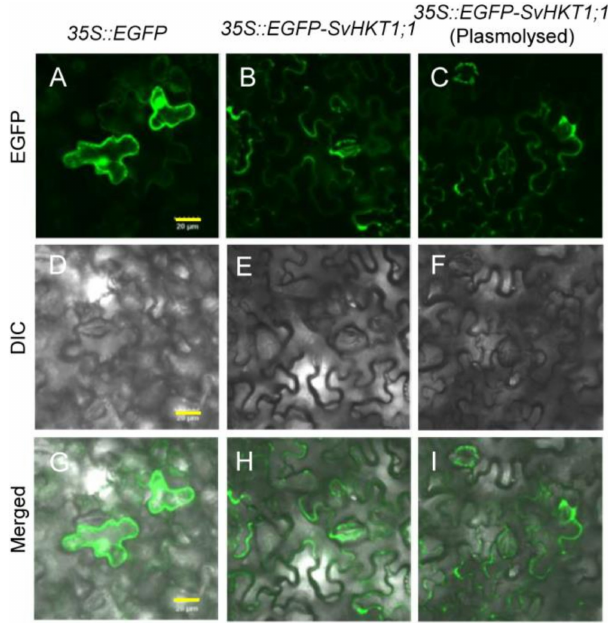
Figure 3. Subcellular localization of EGFP-fused SvHKT1;1 protein in Nicotiana benthamiana leaves. ConfocalfluorescenceimagesofEGFP( A – C ),di ff erentialinterferencecontrastimages( D – F ),andmerged images ( G – I ) of N. benthamiana leaf cells expressing EGFP control ( A , D , G ) and EGFP–SvHKT1;1 ( B , C , E , F , H , I ). Images of non-plasmolyzed ( A – F ) and plasmolyzed ( G – I ) cells. Scale bar represents 20 µ m and is applicable to all panels in this figure.